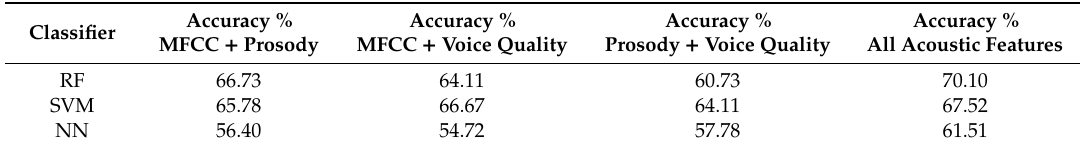
Table 11. Accuracy results for various acoustic feature combinations.